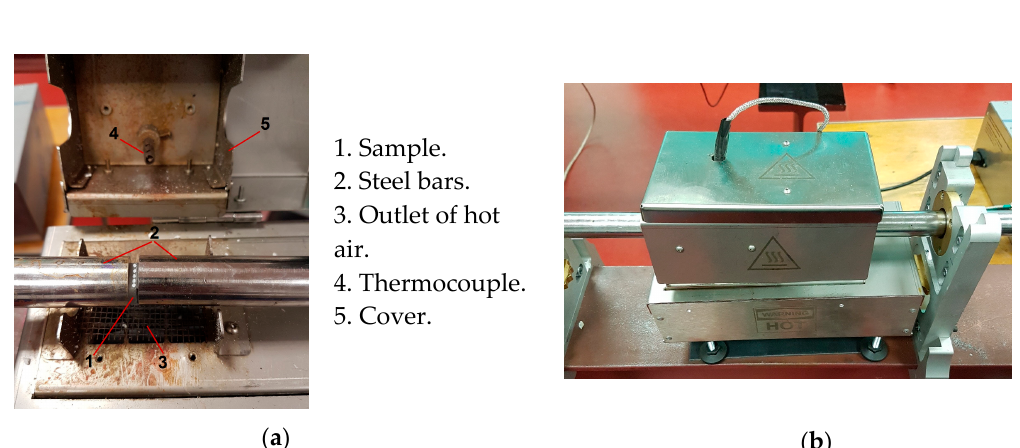
Figure 2. Tests using an electric furnace: ( a ) specimen sandwiched between the bars; ( b ) before the test.